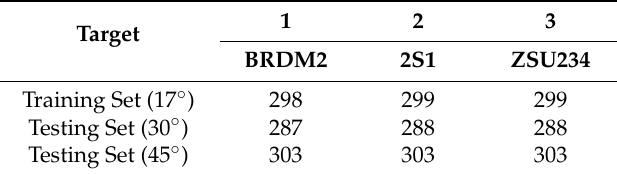
Table 7. Performance of the algorithms in large depression angle experiments.